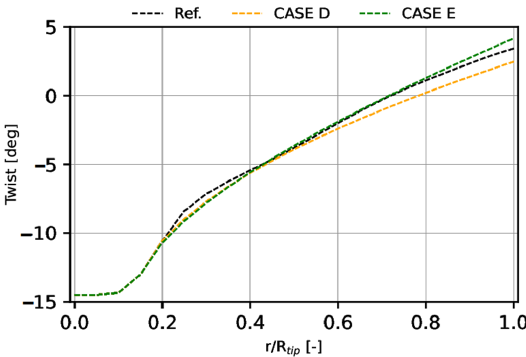
Figure 11. Twist distribution of the cases: reference (A–C), D and E.